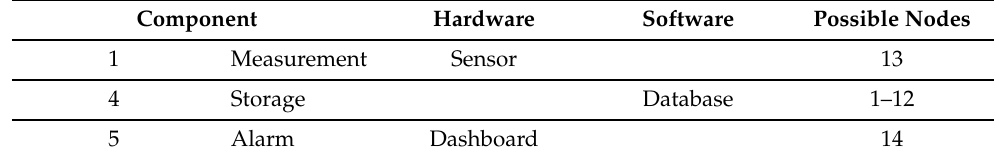
Table 4. Smoke monitoring application constraints.